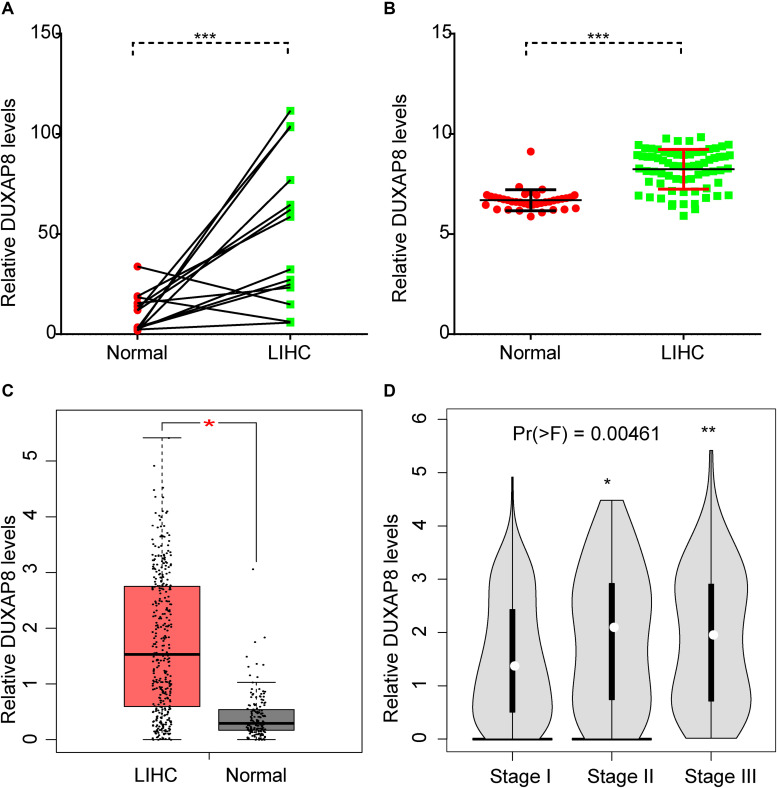
DUXAP8 was upregulated in HCC. (A,B) DUXAP8 expression in HCC tissues was found to be higher than in normal tissue by analyzing GSE84402 and GSE121248. (C) DUXAP8 expression in HCC tissues was found to be higher than in normal tissue by analyzing TCGA. (D) DUXAP8 expression levels were upregulated in Stage II/III compared to Stage I samples. Significance was defined as p < 0.05 (*p < 0.05; **p < 0.01; ***p < 0.001).